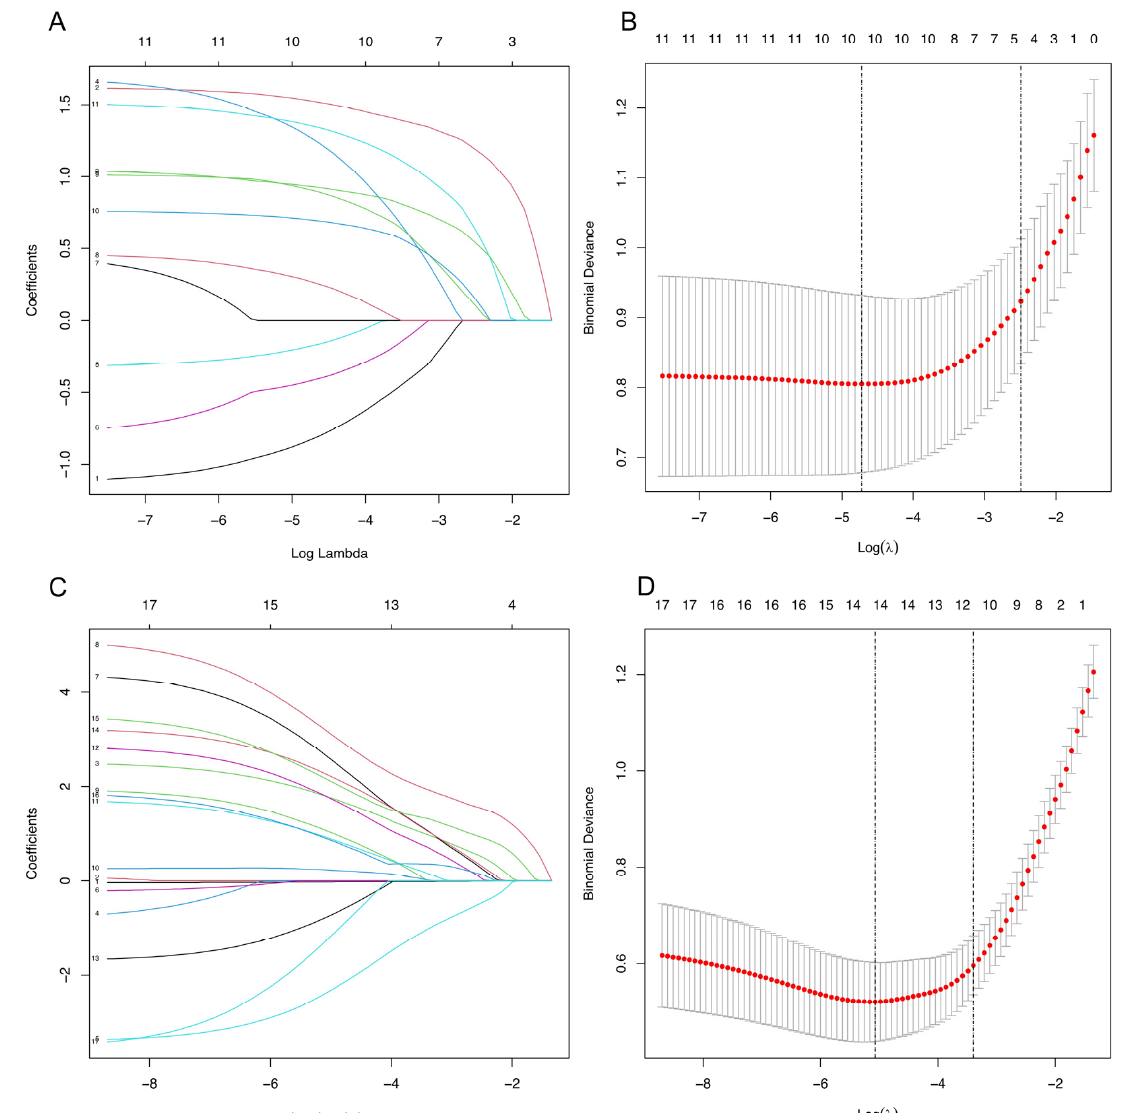
Figure 2. Clinical and laboratory parameter selection using the LASSO binary logistic regression model. ( A , B ) Results for the 11 variables included in the LASSO regression associated with SLE in SLE-SS and the corresponding coefficients for the corresponding variables at different values. ( C , D ) Results for the 17 variables included in the LASSO regression associated with SS and their corresponding coefficients for the corresponding variables at different values of coefficients. LASSO, minimum absolute shrinkage, and selection operators. Table 1. Risk factors for patients with SLE or SS to develop SLE-SS.